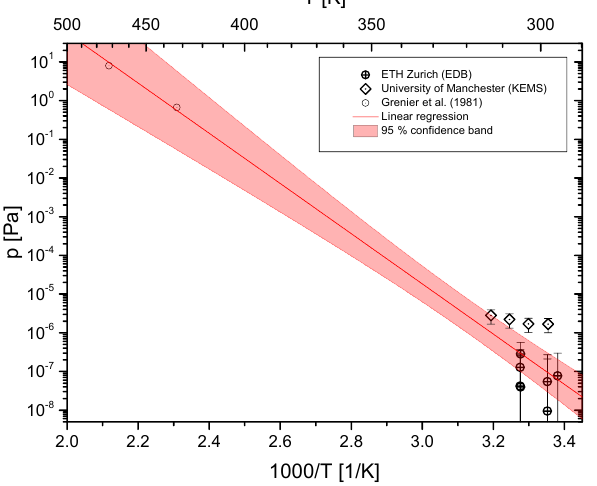
Figure 7. Saturation vapor pressures vs. temperature of octaethy- lene glycol (PEG8). Symbols as in Fig. 2.